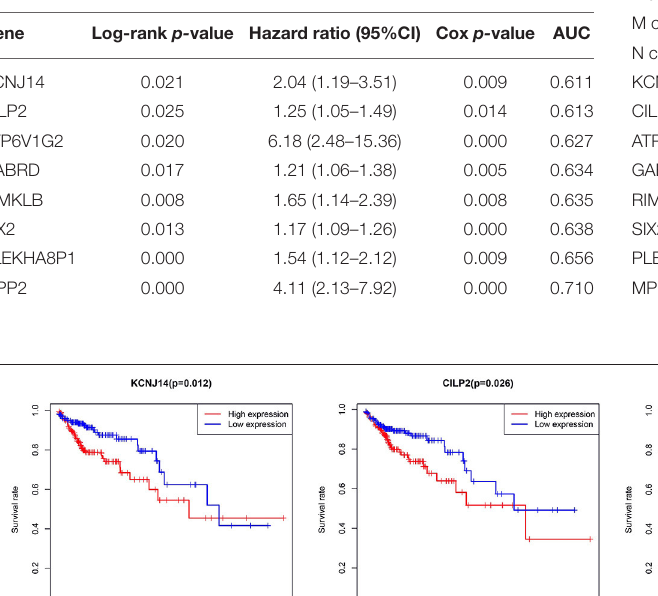
TABLE 2 | Prognostic-related gene in patients with colon cancer.